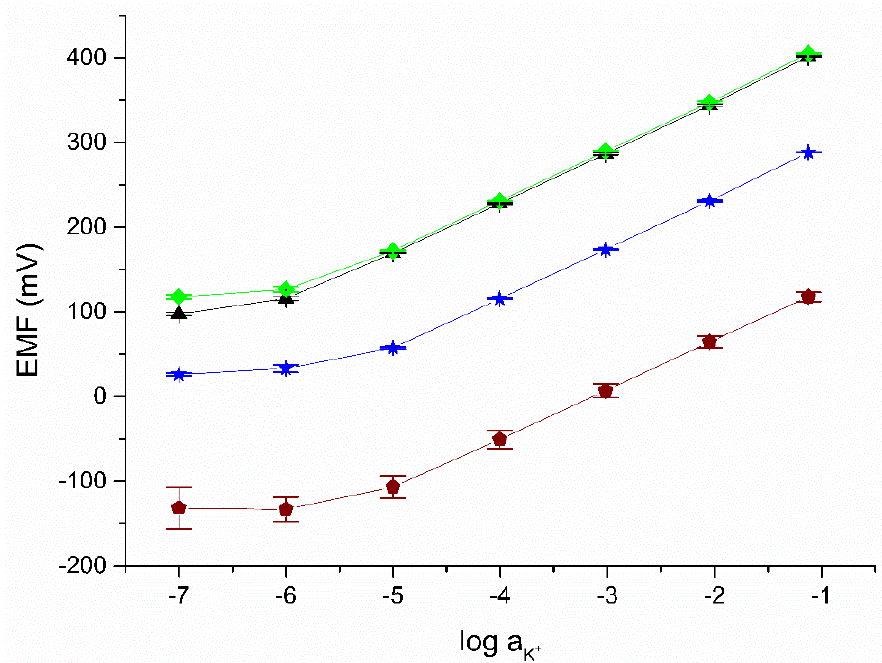
Figure 4. The potentiometric response recorded in KCl solutions for the following electrodes: GC/eCNF+POT/K + -ISM (black), GC/eCNF-Co+POT/K + -ISM (green), hierarchical nanocomposites GC/eCNF/CNT-NiCo + POT/K + -ISM (blue), and coated disc electrode (wine) (n = 3). Table 3. Potentiometric parameters of the investigated K +